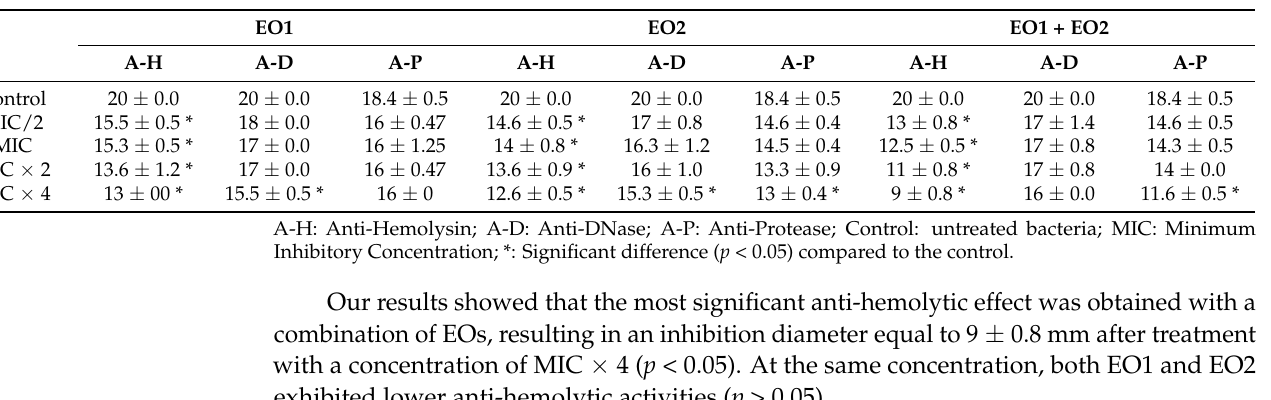
Table 3. Anti-virulence activities of R . officinalis (EO1) and M. communis (EO2) essential oils and their combination (EO1 + EO2) against S. aureus ATCC